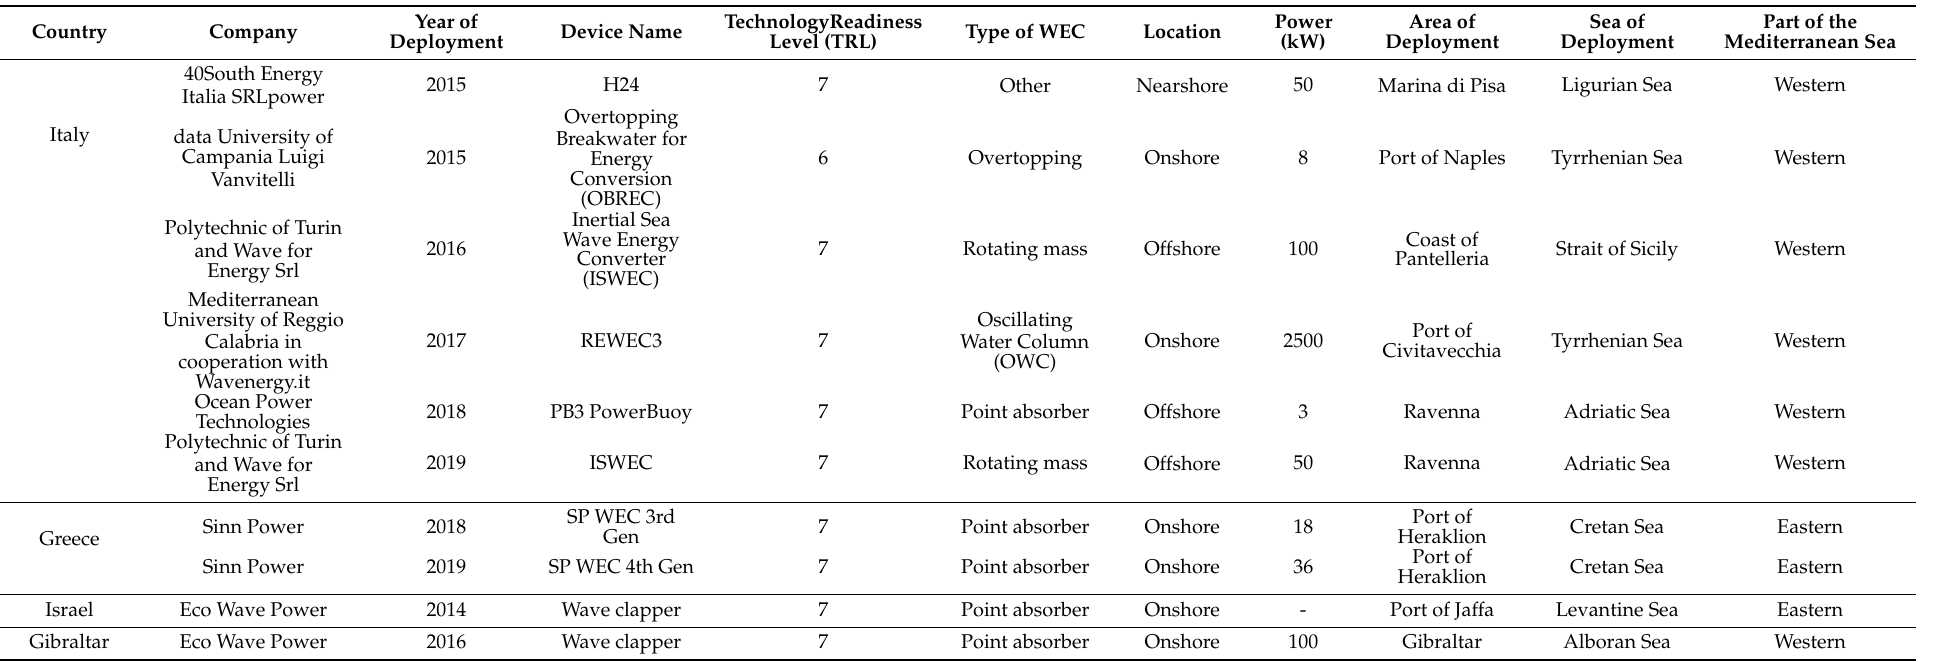
Table 4. Deployed WECs in the Mediterranean